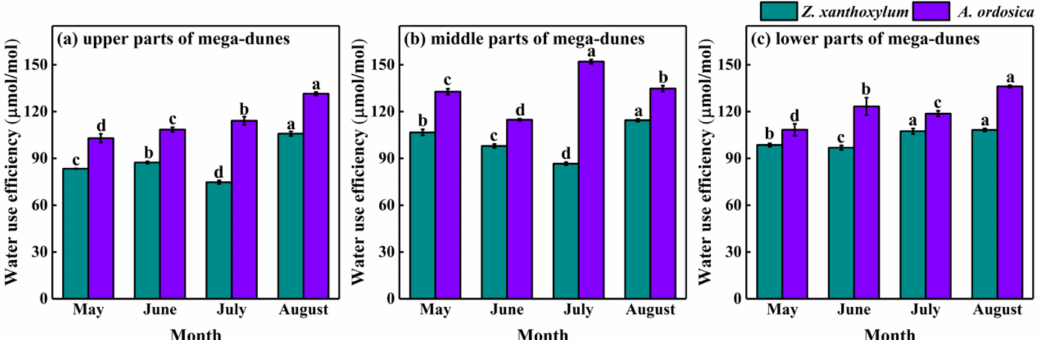
Figure 9. Spatio-temporal variations in water use efficiency for Z. xanthoxylum and A. ordosica . Data are expressed as means ± 1SD. Different lowercase letters express significant differences in plant water use efficiency among months at significance level p <